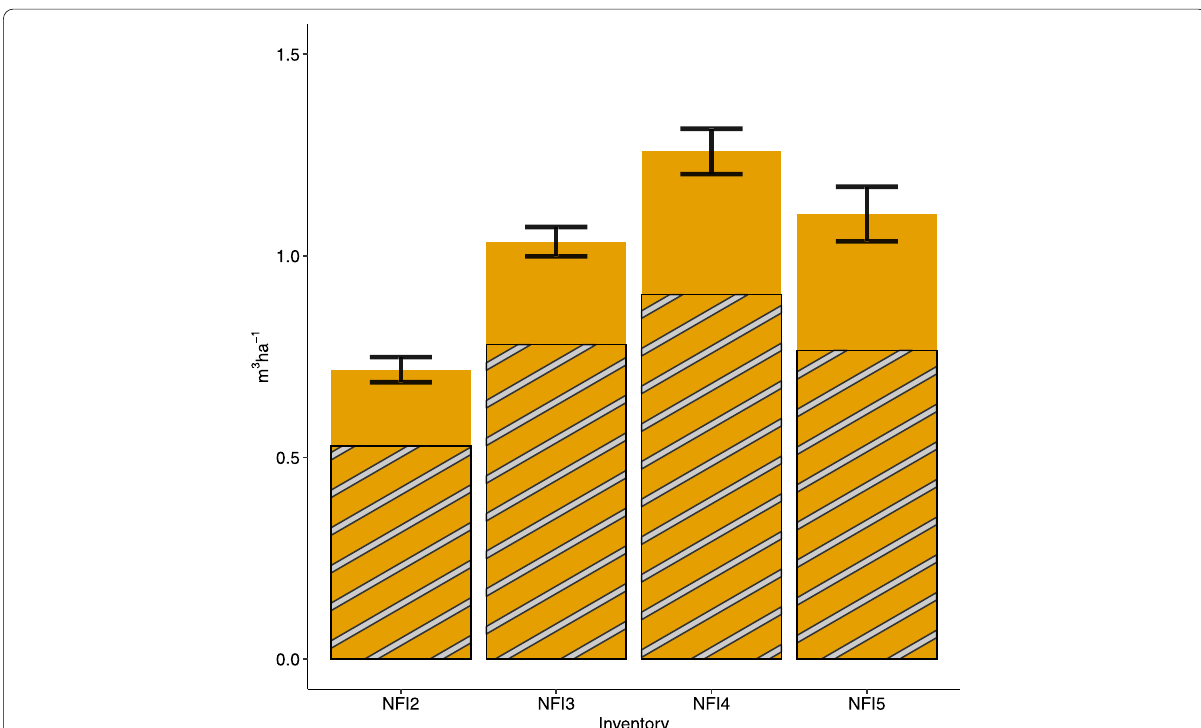
Fig. 2 Simplified cylindric volume (assumption stump height 30 cm, top diameter DBH from previous inventory) for stumps that resulted from = = harvested conifer (dashed) and broadleaf tally trees (i.e., a saw-cut was observed). The error bars indicate one standard error of the total volume of stumps of conifer and broadleaf tree species. The data are based on sample plots common to all five NFIs. The data were standardized based on the time period between the measurements of the sample plots in the NFIs 4 and 5 to account for biases due to different interval times between two consecutive NFIs, i.e., on average 10.1 years between NFIs 1 and 2, 10.8 years between NFIs 2 and 3, 8.8 years between NFIs 3 and 4, and 8.7 years between NFIs 4 and